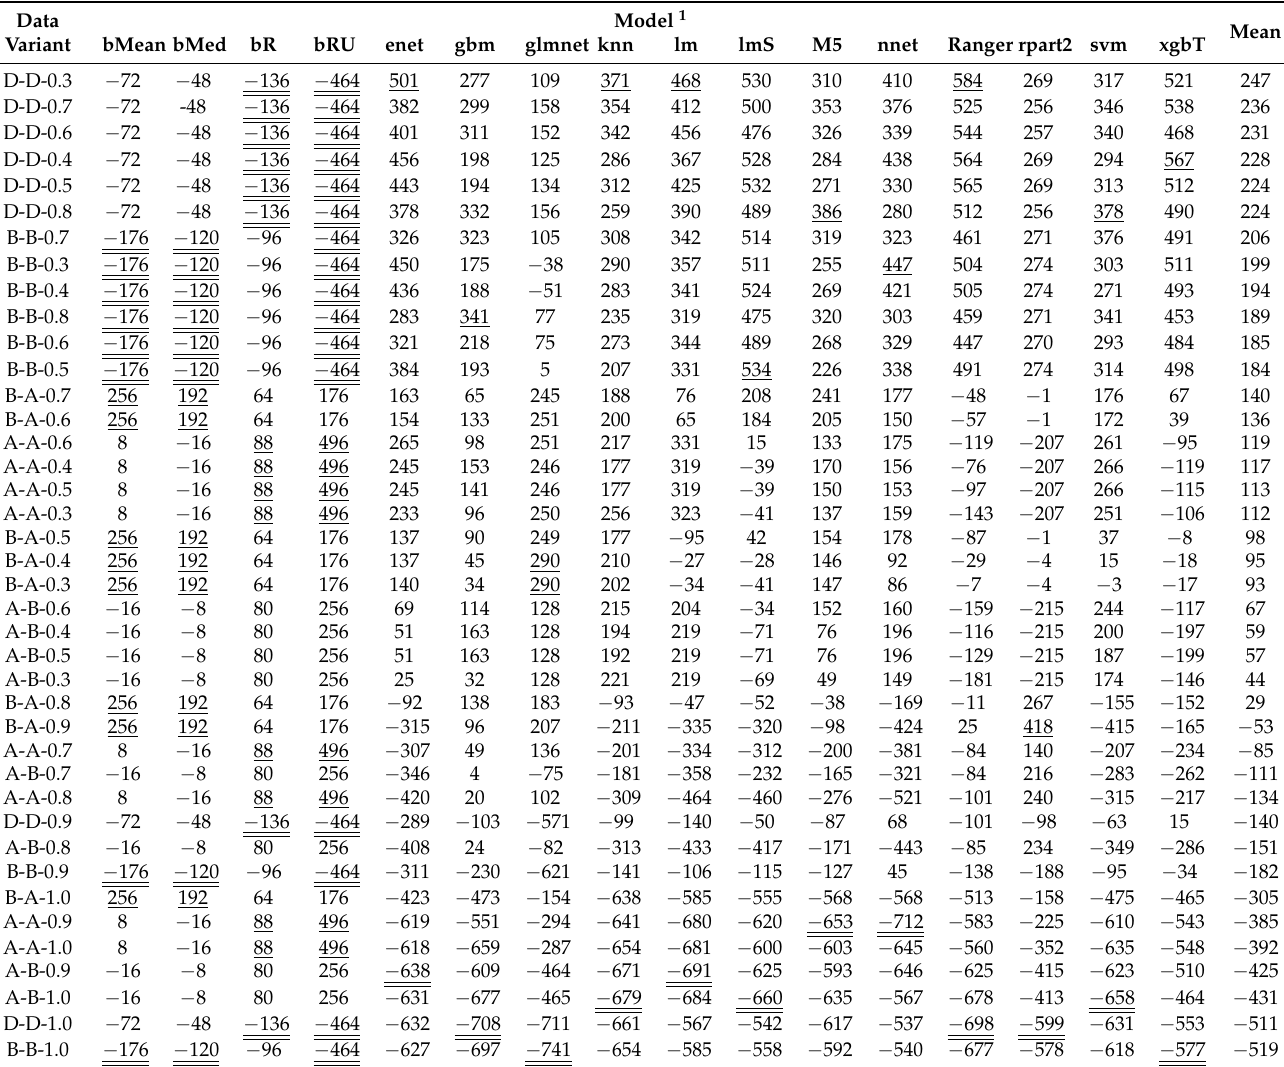
Table 7. The values of the difference of each data variant grouped by each model. The data variants in particular rows were sorted from the best to the worst, according to their mean difference across all models provided in the last column. The models in particular columns were sorted in alphabetical order. Values with a single underline denote the best data variant for a given model, and values with a double underline denote the worst data variant for a given